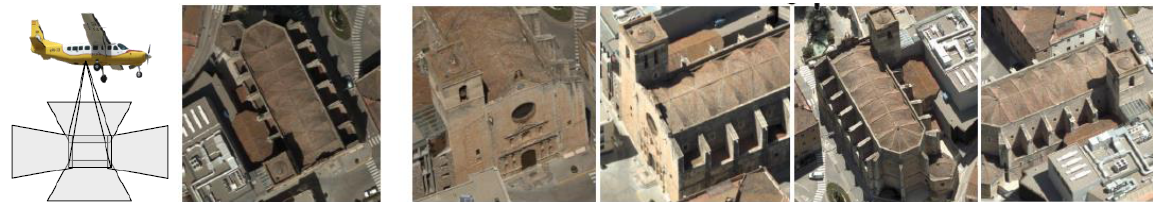
Figure 2: Maltese-cross camera acquisitions: a nadir view and the 4 cardinal views showing building footprints and facades.